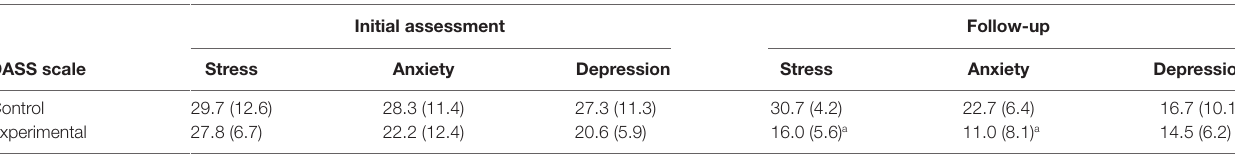
Table 4 | Mean (sD) Dass assessment